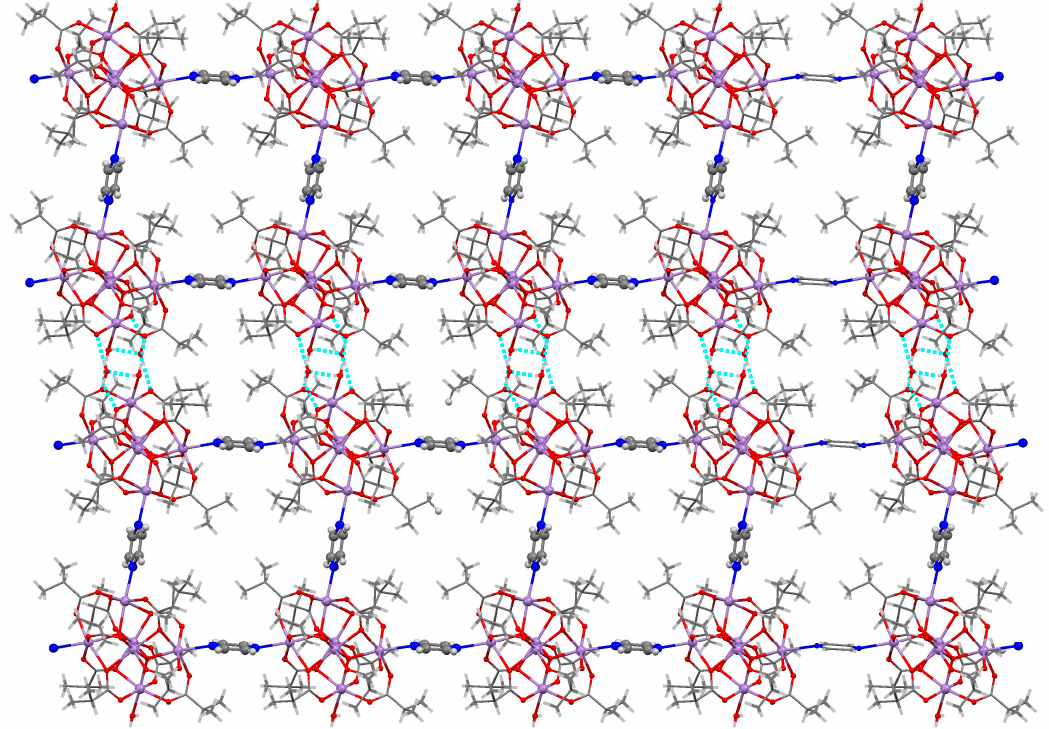
Figure 5. View of the ladder-like 1D coordination polymer of 5 , hydrogen bonded into a supramolecular layer. The bridging pyrazine molecules are shown by bigger radii balls.